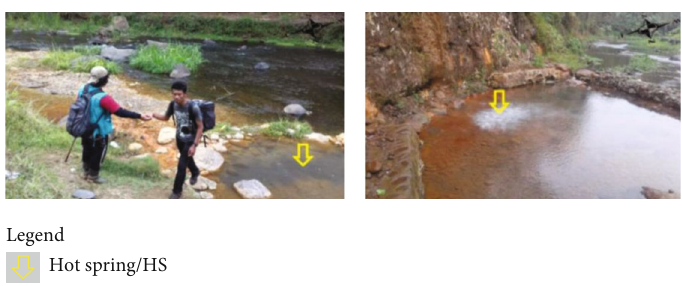
Figure 6: Hot springs on the banks of the Tancak. Watershed